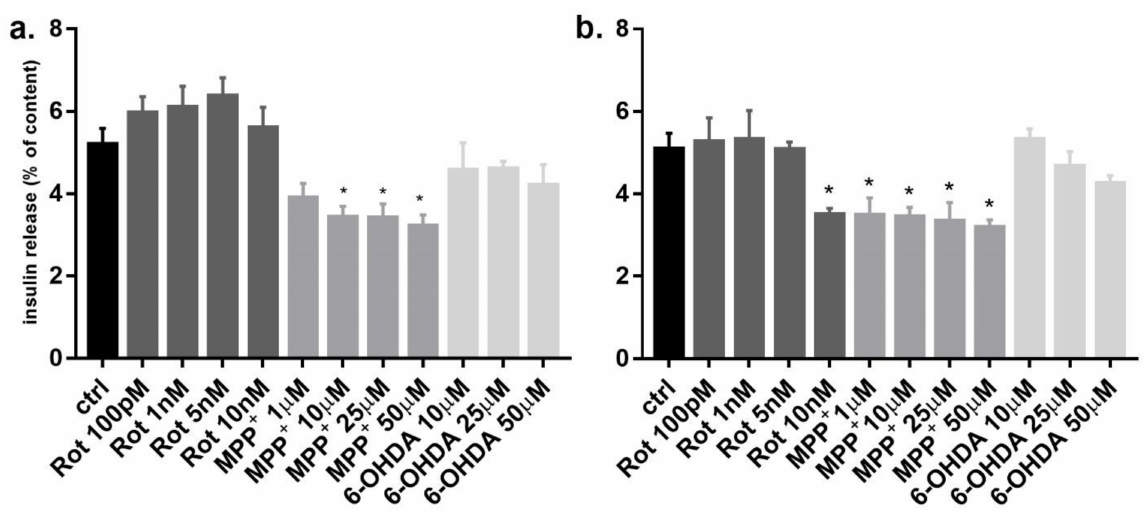
Figure 2. Effect of rotenone, MPP + and 6-OHDA on INS-1 β -cells glucose stimulated insulin release. INS-1 cells were incubated for 6 h ( a ) and 24 h ( b ) at high glucose concentration (11 mM) in the presence of non toxic increasing concentration of rotenone, MPP + and 6-OHDA. Insulin secretion was measured and expressed as percentage of the cellular insulin content. Data are expressed as mean ± SEM of three independent experiments. * p < 0.05 compared to control, ANOVA, Dunnett post hoc